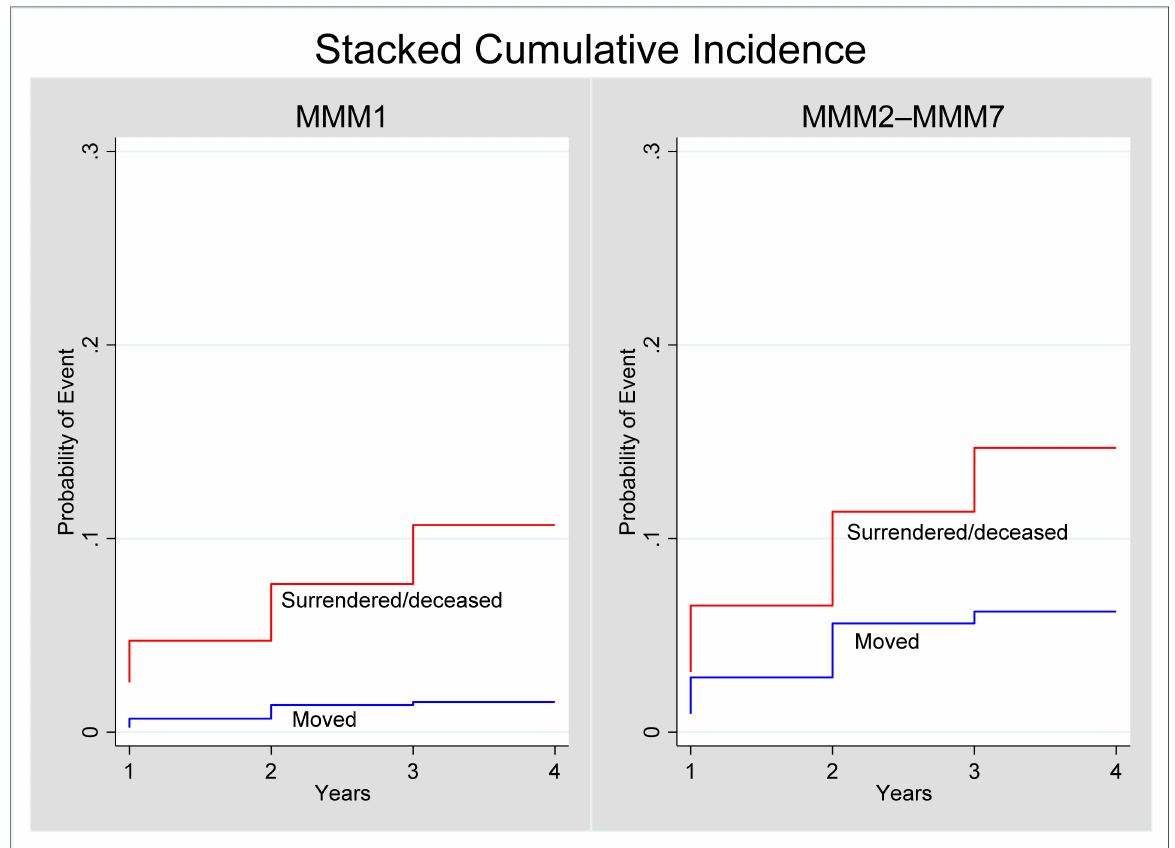
Figure 2. Stacked cumulative incidence plots for moving primary place of practice MMM or leaving due to other